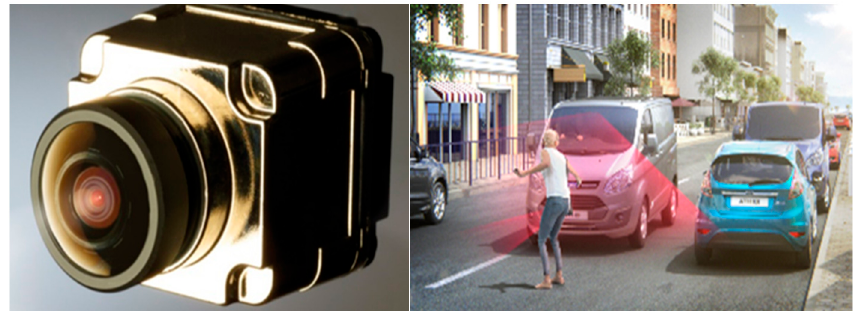
Figure 7. Pedestrian detection using SVC cameras. A Valeo 360 surround view camera could offer a three-dimensional view of the environment. (Image source: www.valeo.com/en/360-vue/ and www.fordclubsweden.se; accessed on 12 March 2021).